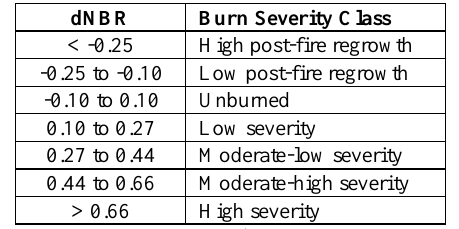
Table 2. Burn Severity Classes (from Key and Benson, 2006)